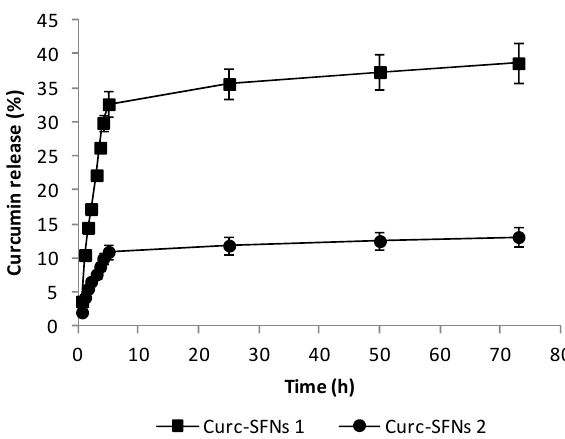
Figure 4. Curcumin release from curcumin-loaded silk fibroin nanoparticles synthesized by physical adsorption (Curc-SFNs 1) and curcumin-loaded silk fibroin nanoparticles synthesized by coprecipitation (Curc-SFNs 2) in PBS 1× (0.5% Tween 80) at 37 °C.